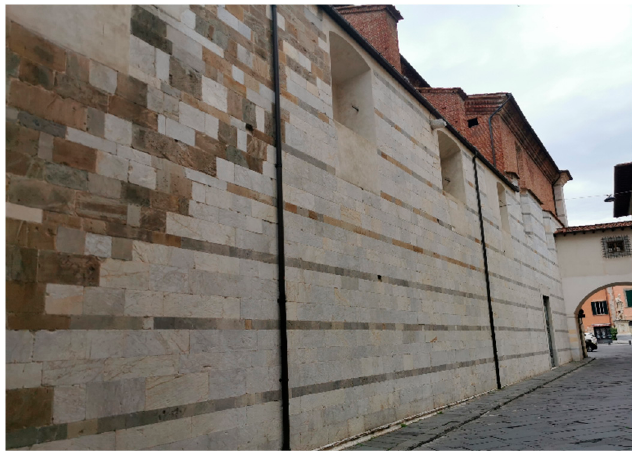
Figure 28. The actual aspect of the south façade (June 2021).